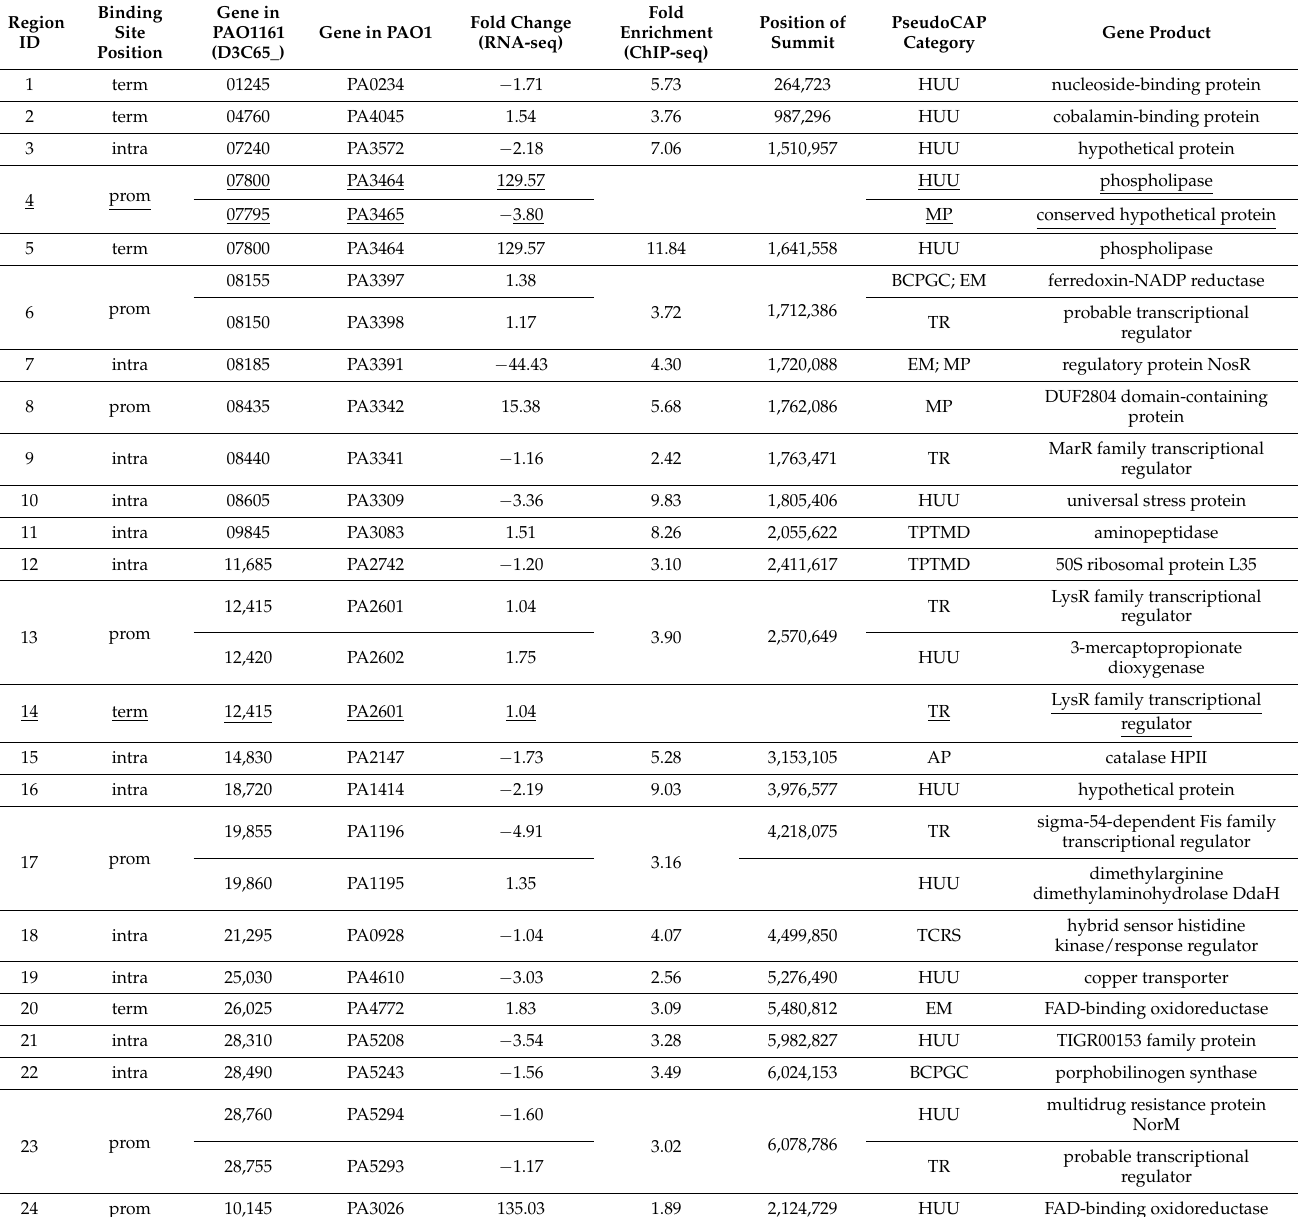
Table 2. P. aeruginosa loci with PA3027 binding sites identified in the ChIP-seq